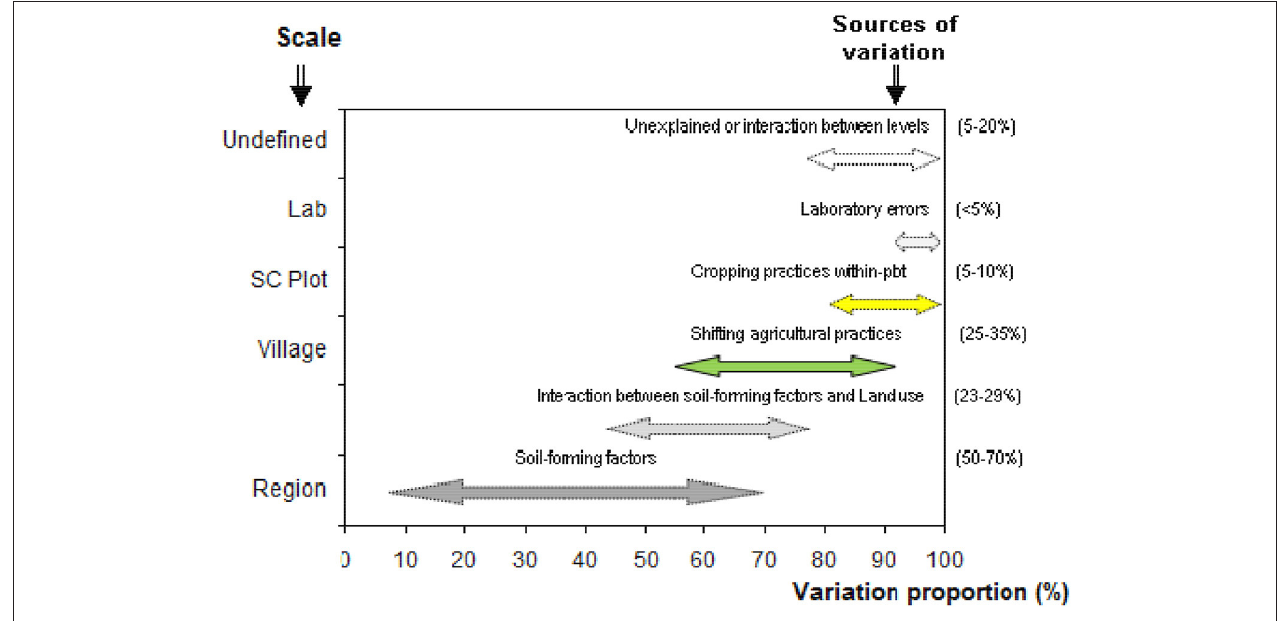
FIGURE 5 | Sources and scale of soil variability within the SALMS of southern